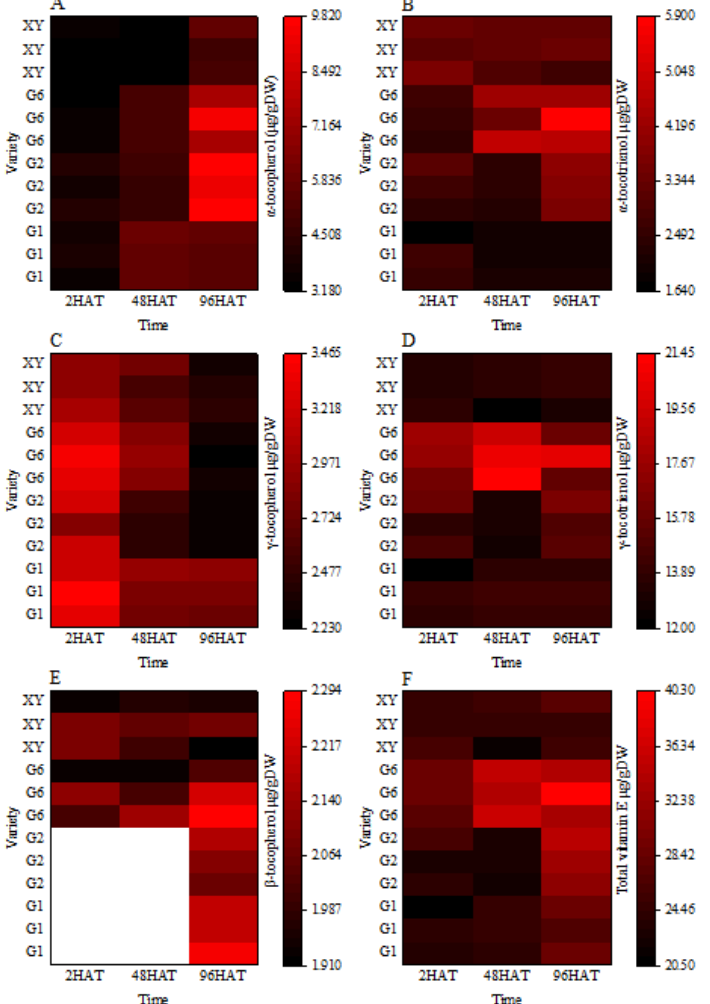
Figure 3. Heat map of the dynamic changes in vitamin E isomer content in brown rice during germination. ( A ): The α -tocopherol content. ( B ): The α -tocotrienol content. ( C ): The γ -tocopherol content. ( D ): The γ - tocotrienol content. ( E ): The β -tocopherol content. ( F ): The total vitamin E content. Treatments: 2 h after seed soaking treatment (2HAT), 48 h after seed soaking treatment (48HAT), 96 h after seed soaking treatment (96HAT). Varieties: Guanghei1 (G1), Guichao2 (G2), Guanghong6 (G6), Xiangyaxiangzhan (XY). The white section in the heat map was not detected.